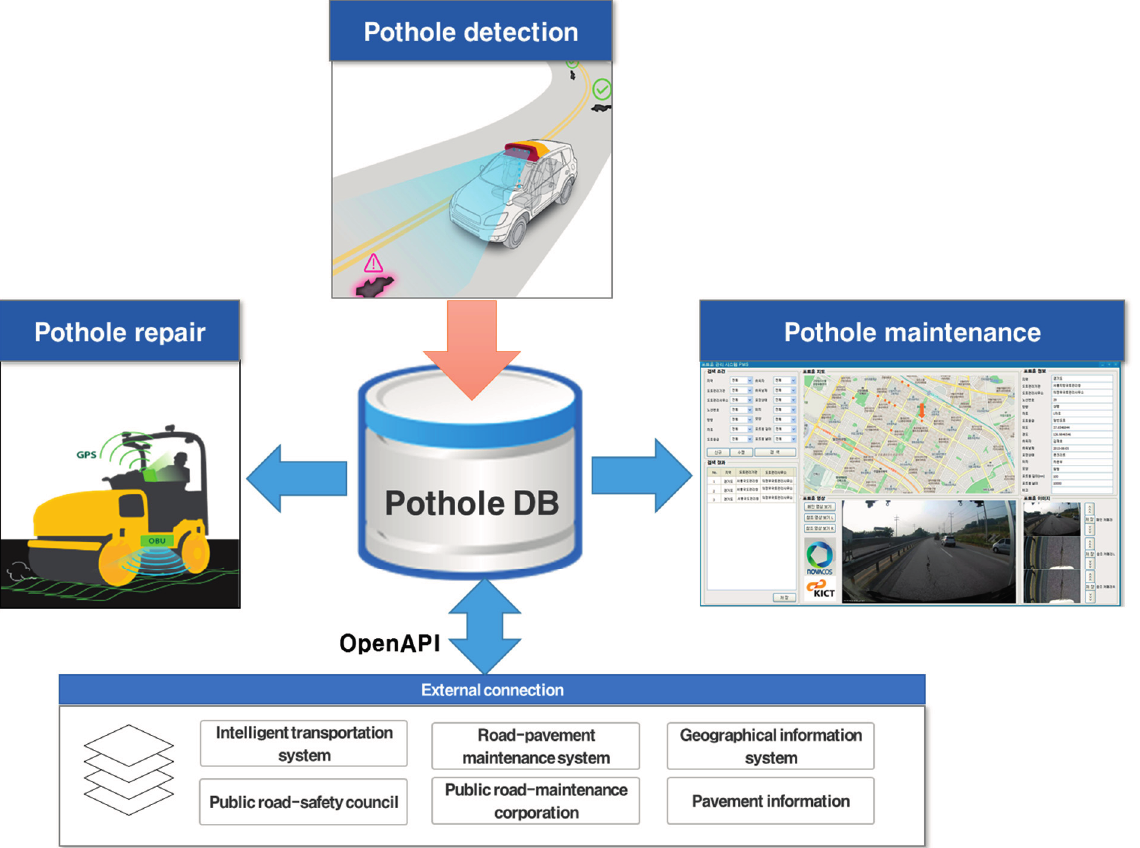
Figure 1. Proposed pothole-maintenance